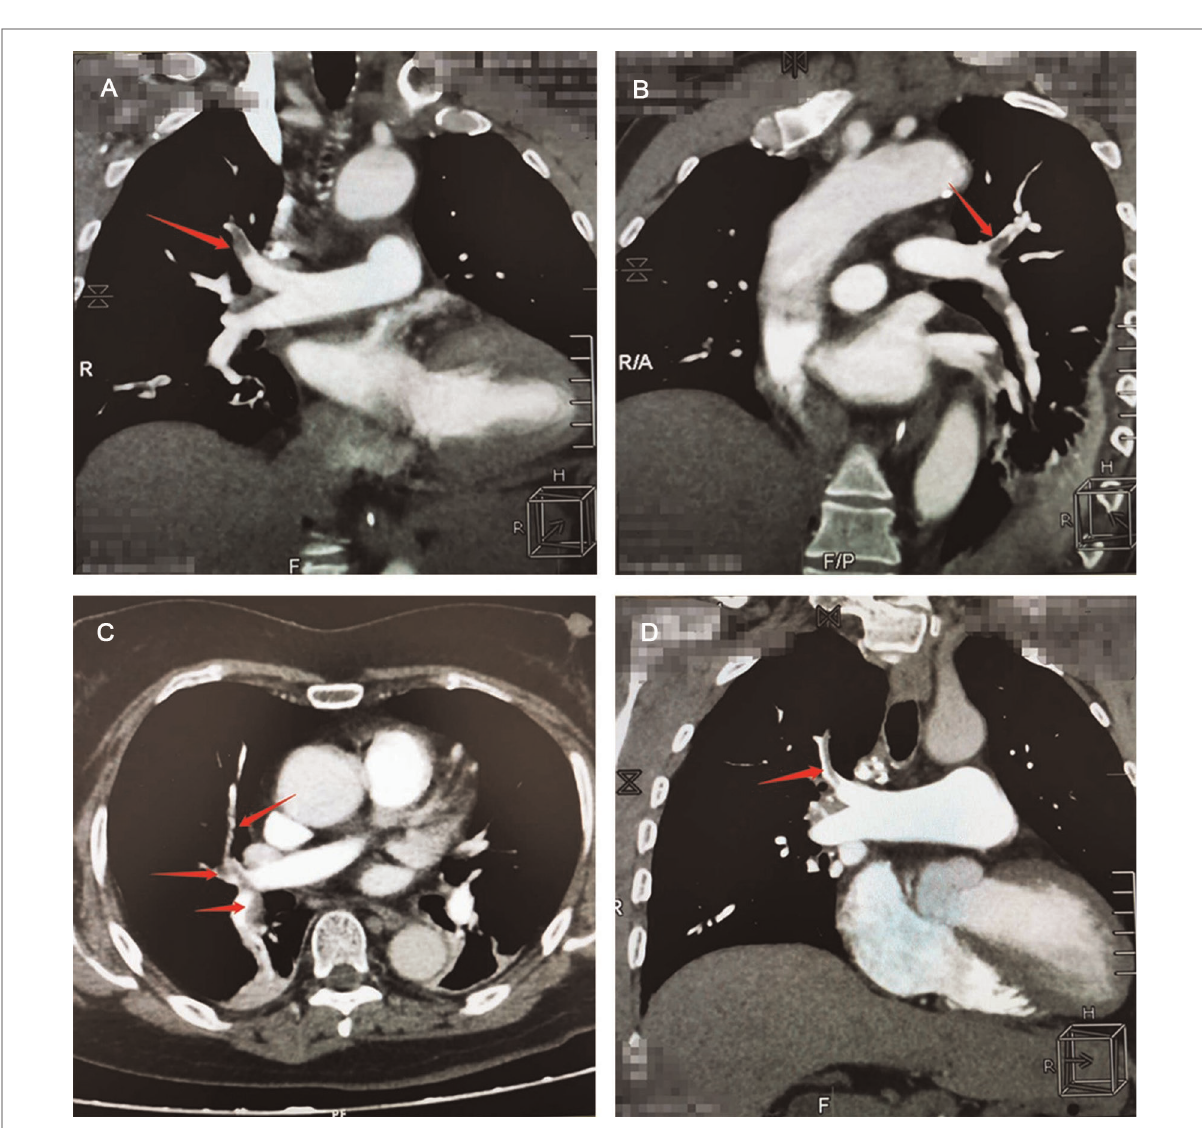
FIGURE 1 Representative computed tomographic pulmonary arteriography (CTPA) images of pulmonary embolism (PE). ( A ) CTPA shows fi lling defects in the right upper pulmonary artery (red arrow). ( B ) CTPA shows fi lling defects in the left upper pulmonary artery (red arrow). ( C ) CTPA shows fi lling defects in the right upper pulmonary artery, right middle pulmonary artery, and right lower pulmonary artery (red arrow). ( D ) CTPA shows fi lling defects in the right upper pulmonary artery (red